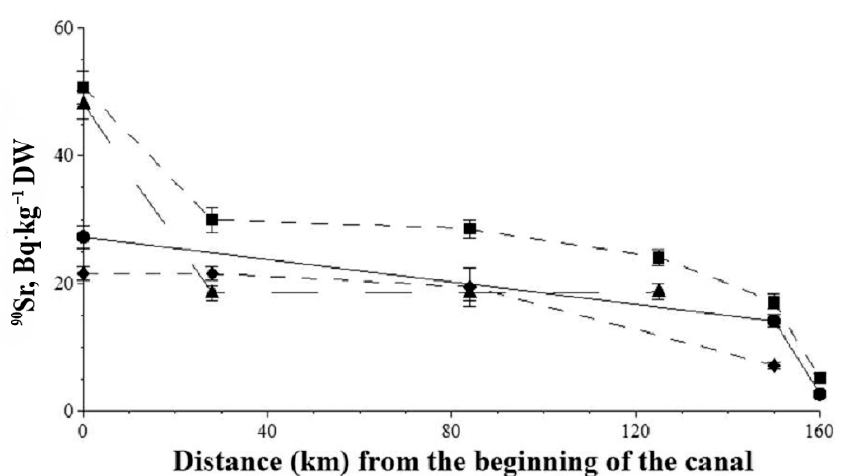
Figure 4. 90 Sr concentrations in bottom sediments of the NCC main canal (1992 ( • ), 1993 ( (cid:78) ), 1994 ( ◆ ), and 1995 ( ◼ )).